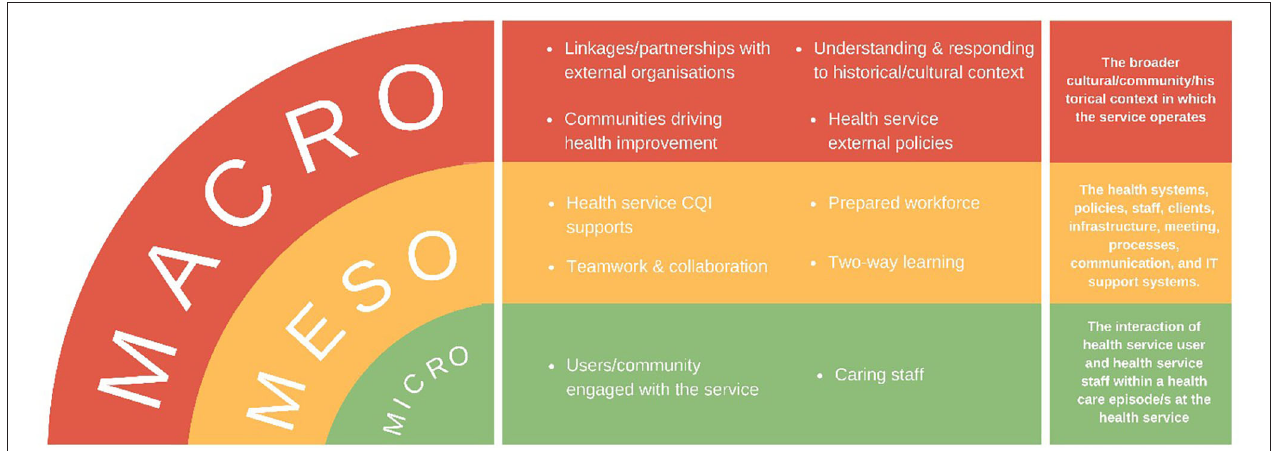
FIGURE 1 | Factors influencing continuous quality improvement (CQI) at high-improving services (10, p.